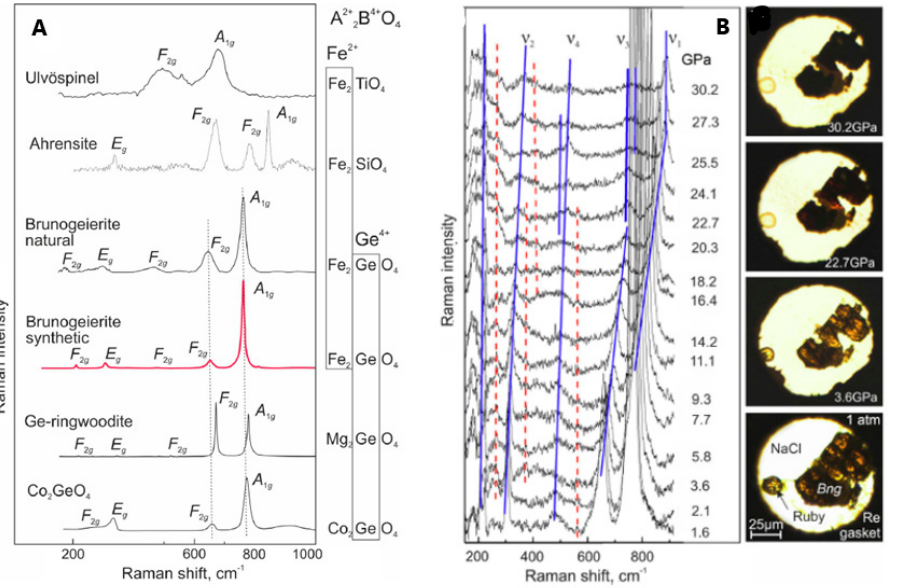
Figure 6. ( A ) Raman spectra of Fe 2+ and/or Ge 4+ AB 2 O 4 spinels; ( B ) Raman spectra of synthetic brunogeierite single crystal at pressures up to 30 GPa (blue lines—shifting trends of the main bands, red dotted lines—shifting trends of the extra bands) and images of brunogeierite crystal (Bng) under compression [26]. Reproduced with permission, Copyright Elsevier 2022.